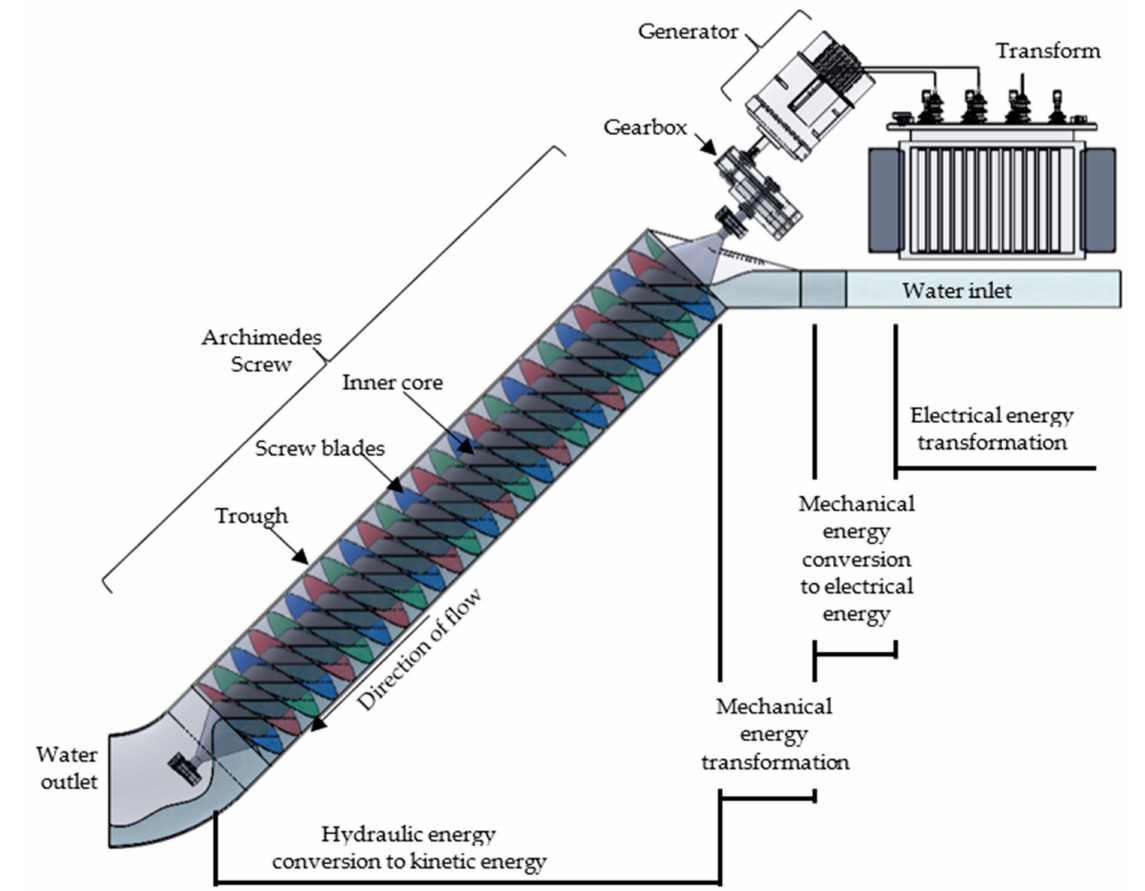
Figure 1. Energy conversion inside the AST hydro plant.